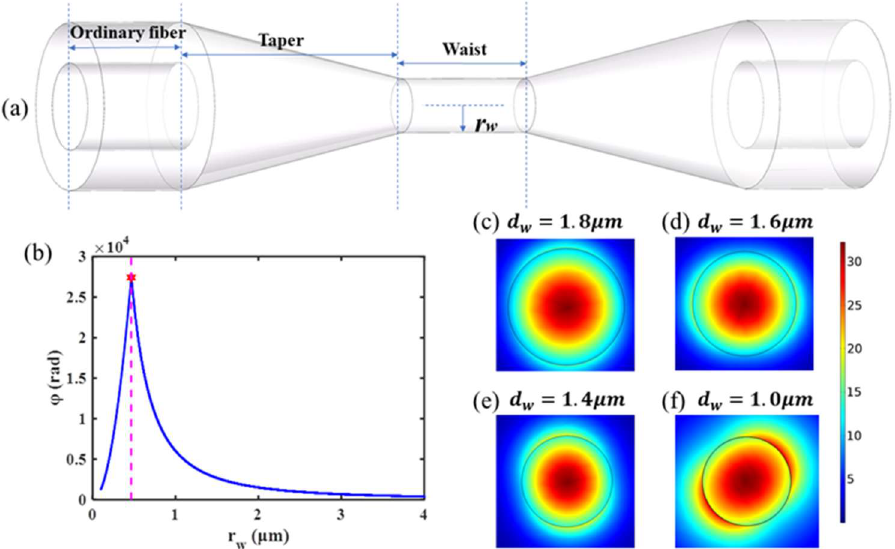
Figure 1. ( a ) The schematic diagram of the optic microfiber. ( b ) The relation between the phase response of OM induced by the photo-induced thermal phase shift effect and the radius r w . ( c – f ) Energy distribution of the uniform waist area of OM with different diameters.